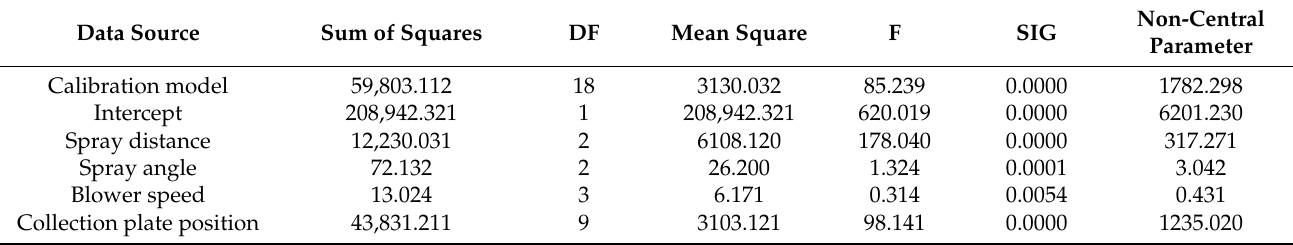
Table 3. Inter-subject effect